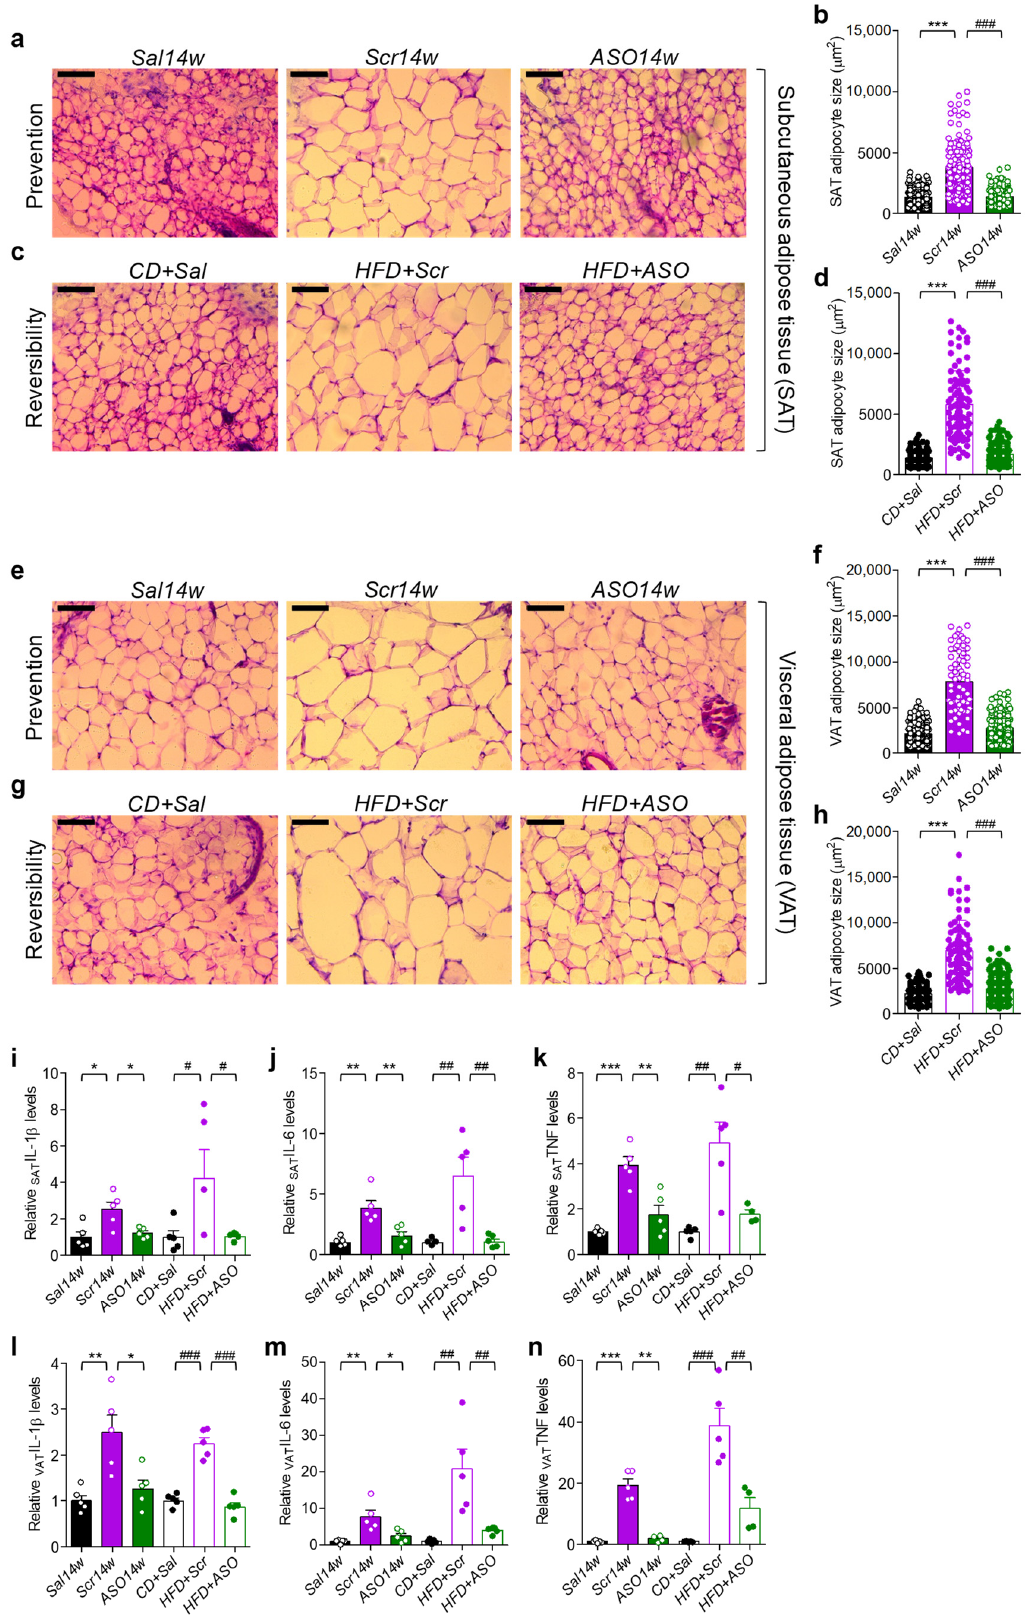
Figure 2. Effect of apoCIII reduction on size of adipocytes and inflammatory cytokines in SAT and VAT. ( a – h ) Representative microphotographs and quantitative analyses of hematoxylin and eosin–stained cryosections from SAT from the ( a , b ) prevention and ( c , d ) reversibility studies and